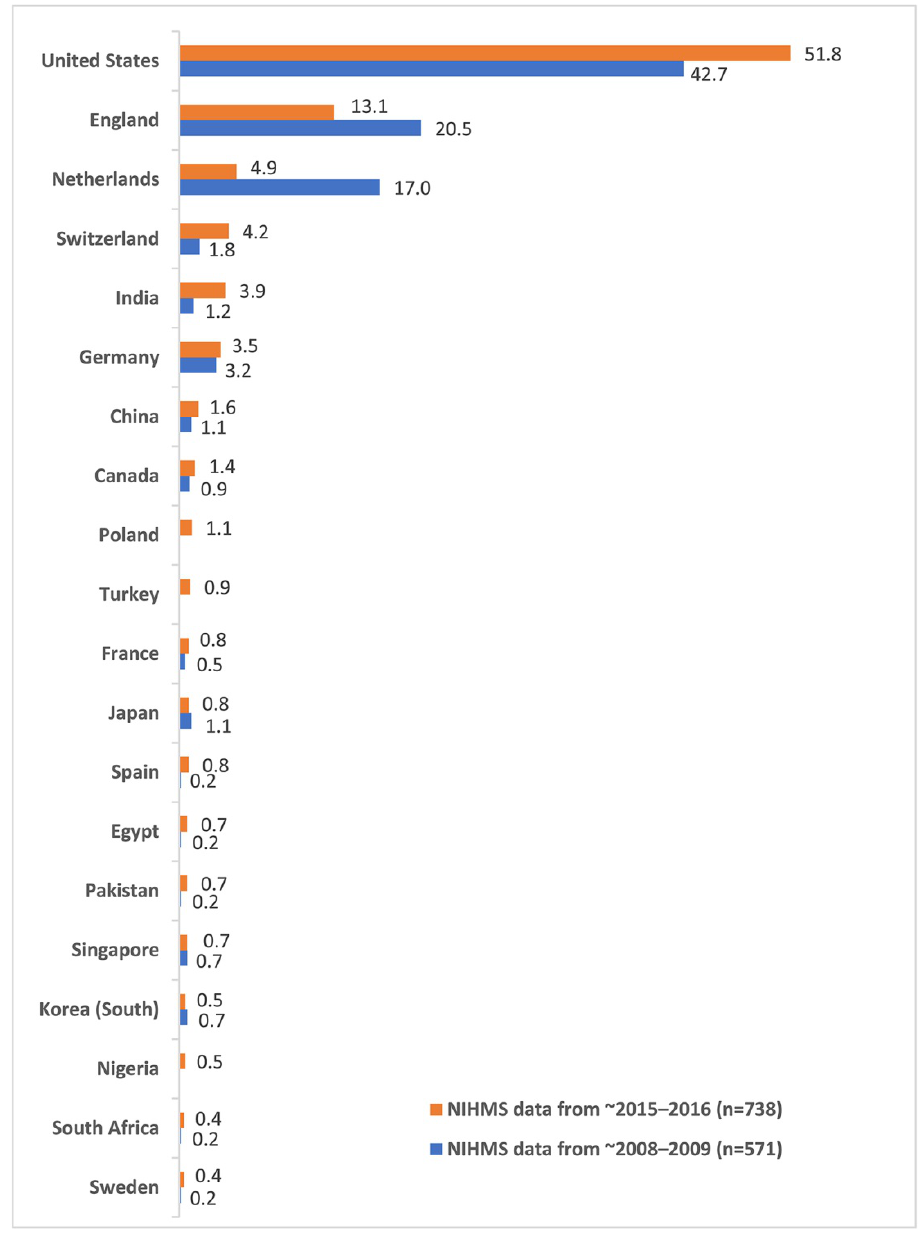
The top 20 countries according to ~2015–2016 NIHMS data are shown and compared to the corresponding percentage of publications from ~2008–2009 data. When no percentage is reported for a country, the number of publications is 0. ~2008–2009 NIHMS data were taken from a previously published study